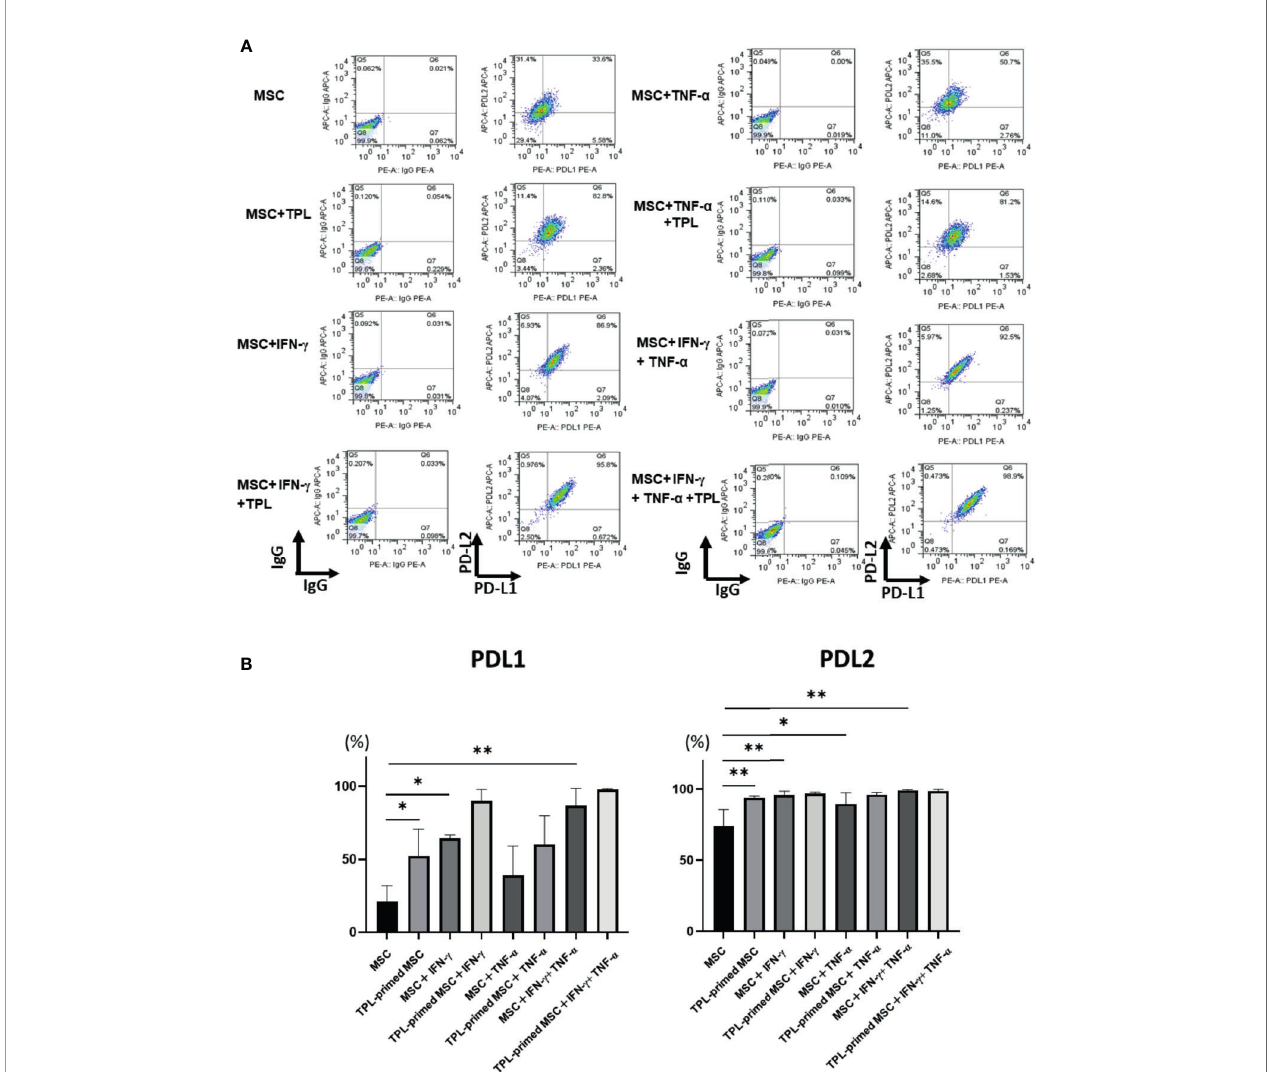
FIGURE 6 | PD-L1 and PD-L2 expression in TPL-primed or non-primed UC-MSCs in the presence of IFN- g and/or TNF- a . PD-L1 and PD-L2 expression in TPL- primed UC-MSCs and non-primed UC-MSCs in response to IFN- g and TNF- a . (A) FACS analysis of PD-L1 and PD-L2 expression. The representative data of three independent experiments are shown. (B) Quantitative analysis. Quantitative data have been presented as the mean value of three different samples ± SD with *p < 0.05, **p < 0.01. MSC,